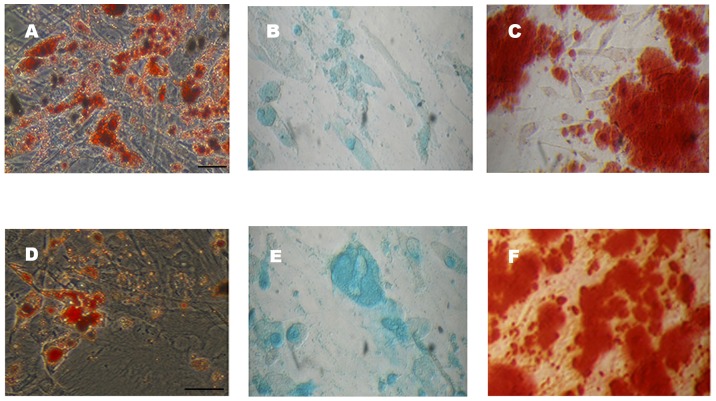
Differentiation potential of ADSCs from cancer patients and non-oncogenic participants.Representative microscopic images of differentiated in vitro expanded ADSCs from cancer patients (A–C) and non-oncogenic participants (D–F). Adipogenesis was evidenced by Oil Red-O staining (A, D); chondrogenesis by glycosaminoglycan alcian blue staining (B, E) and osteogenesis by alizarin red staining (C, F) after 15 days of differentiation induction (Scale bar  = 0,2 pixels).